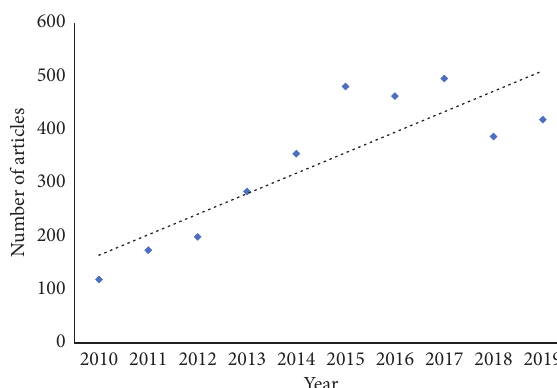
Figure 1: Number of Chinese publications in the period of ten years